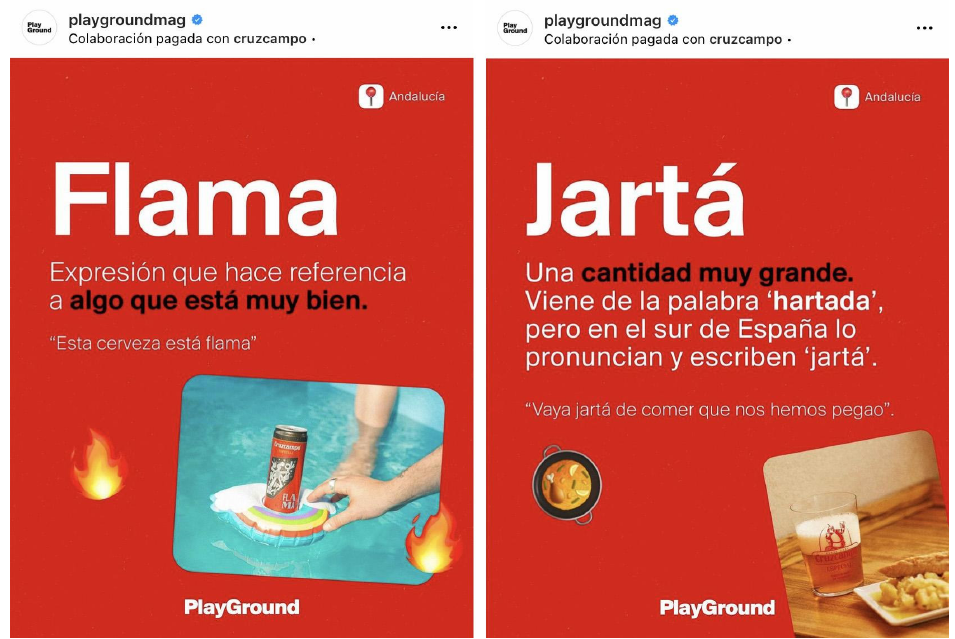
Figure 5. A social media action by Playground Magazine for Cruzcampo comprising a glossary of Andalusian slang as part of the campaign carried out by the brewers to emphasise their pride in being Andalusian.